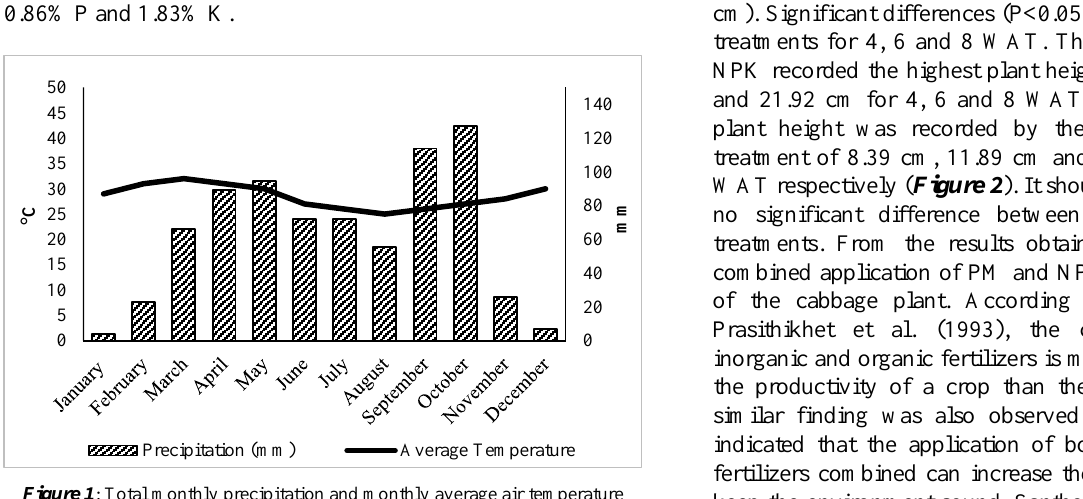
Figure 1 : Total monthly precipitation and monthly average air temperature (2017)